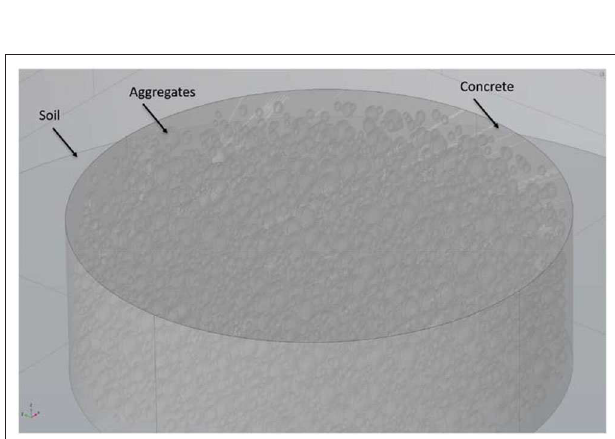
FIGURE 2 | Demonstration of aggregates distribution within a 2-D beam. A void gap line represents the location of optical fiber placed in the beam. Different colors of the aggregates represent certain size ranges.